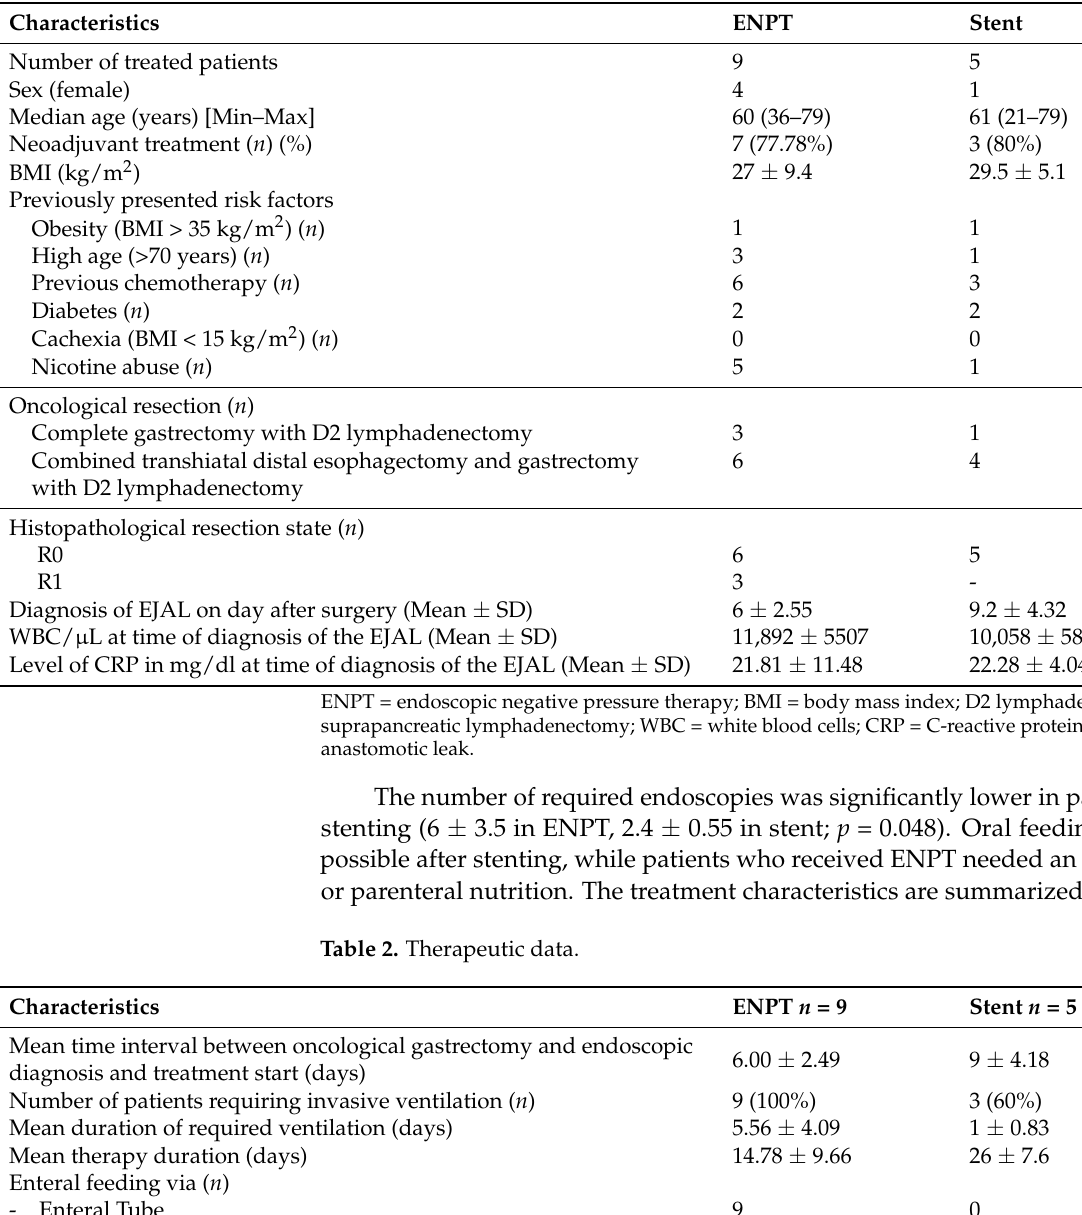
Table 1. Patients’ characteristics.